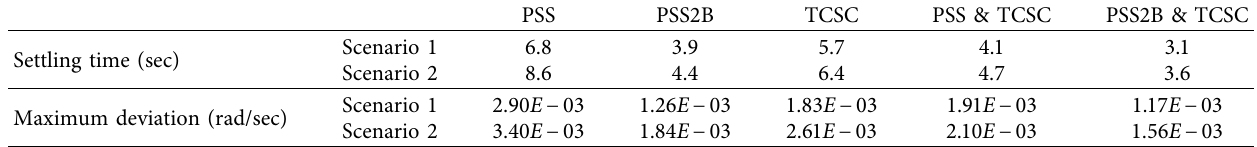
Table 7: Te ITAE and FD